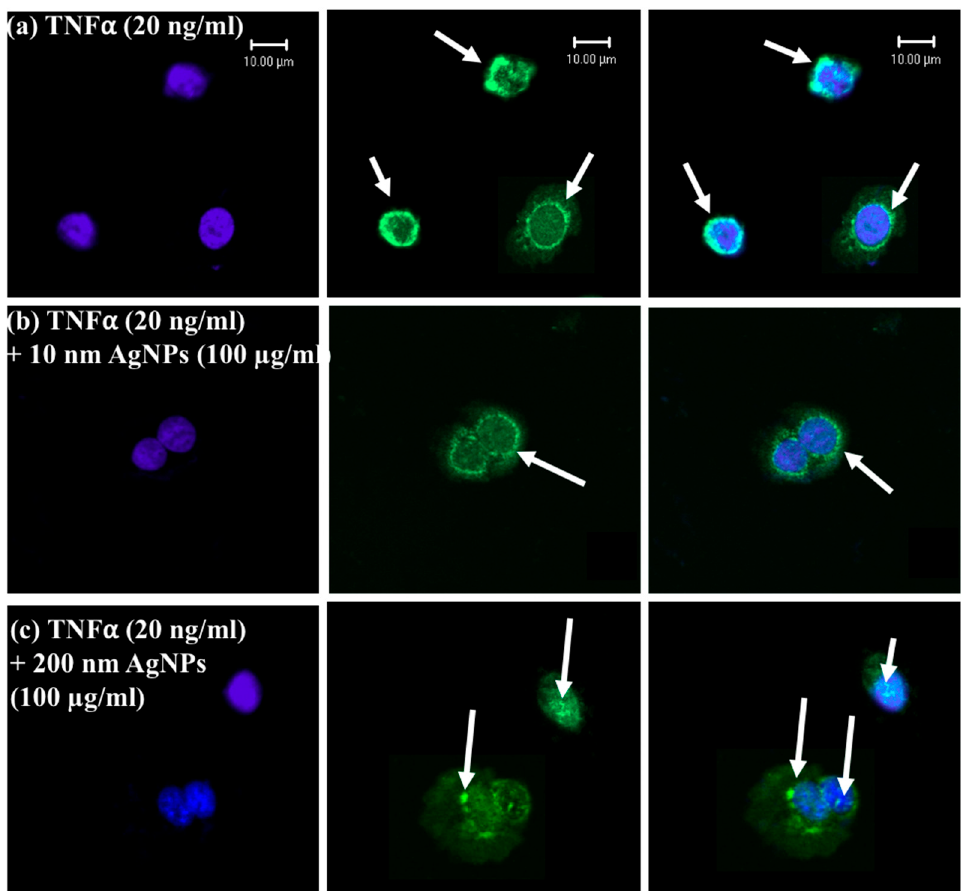
Figure 6. Localization of TNFR1 in NCI-H292 cells using confocal microscopy. Blue shows the nucleus, green shows the receptors (TNFR1), and blue and green together are the merged form. White arrows show TNFR1. ( a ) NCI-H292 cells were exposed to TNF α (20 ng/mL), and TNFR1 was distributed on the cell membrane with some aggregations. ( b ) NCI-H292 cells were exposed to both TNF α (20 ng/mL) + 10 nm AgNPs (100 µ g/mL), and TNFR1 localization was scattered over the entire cell membrane. ( c ) NCI-H292 cells were exposed to both TNF α (20 ng/mL) and 200 nm AgNPs (100 µ g/mL), and TNFR1 was localized inside cells with very few receptors on the cell membrane. Exposure was 24 h for all experiments. Scale bar is 10 µ m for all panels.